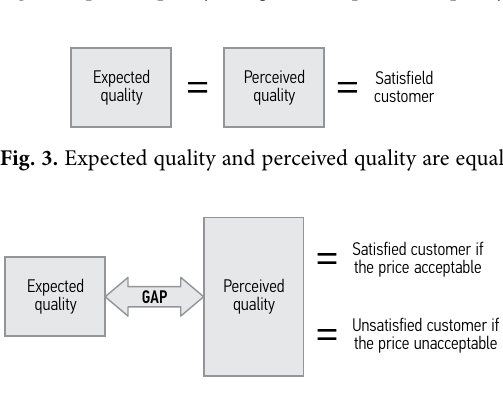
Fig. 4. Expected quality is lower than perceived quality